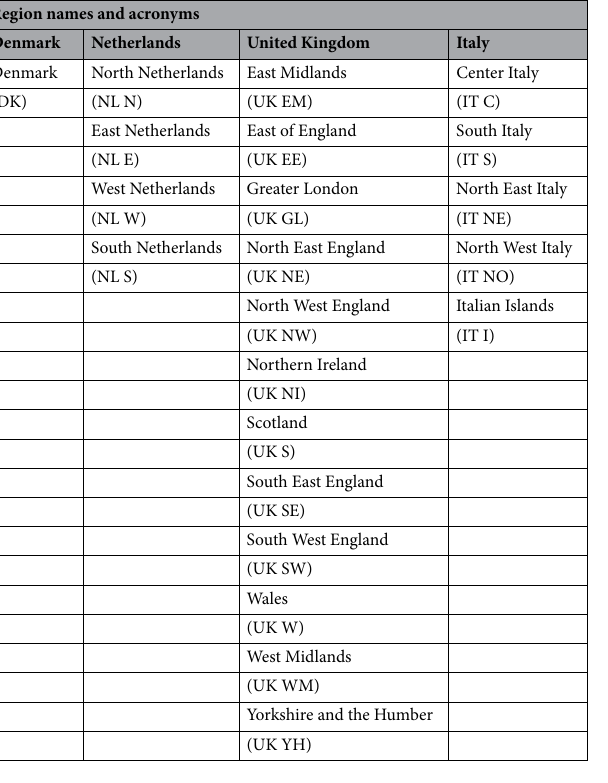
Table 1. The 22 regions analyzed (NUTS2 territories) divided by